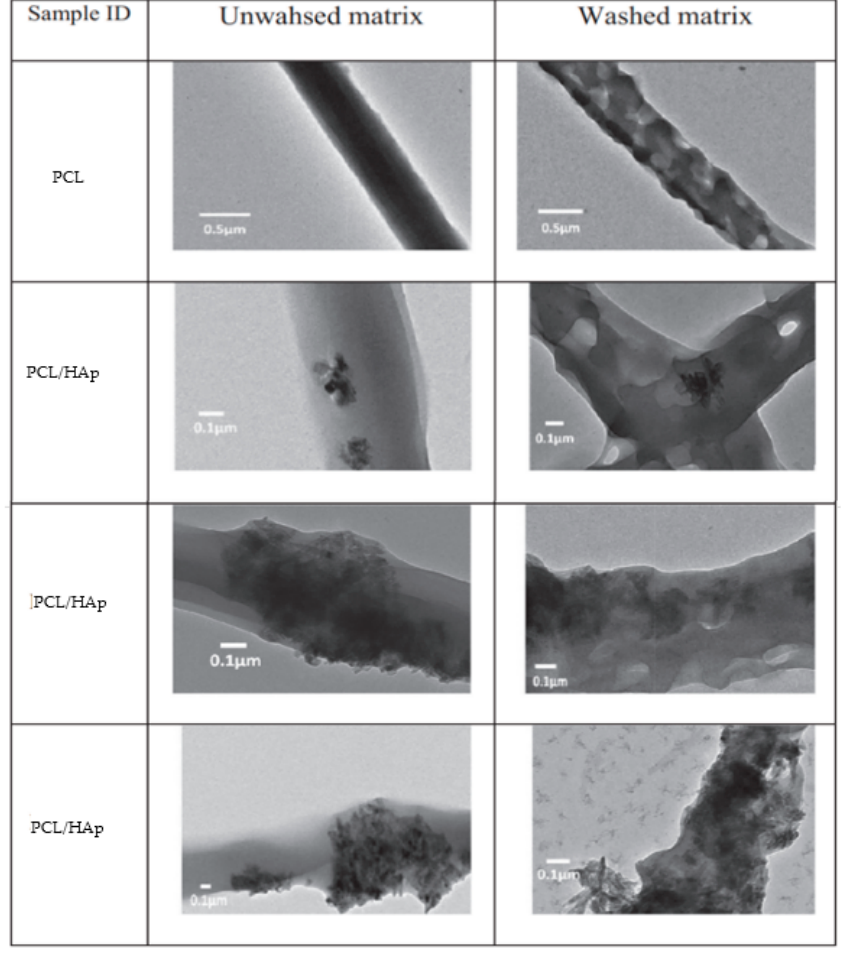
Figure 17. TEM images of unwashed and washed matrices of PCL and PCL/HAp (10%, 30%, and 40% of HAp with respect to PCL) obtained by emulsion electrospinning. Reproduced with permission from [274].